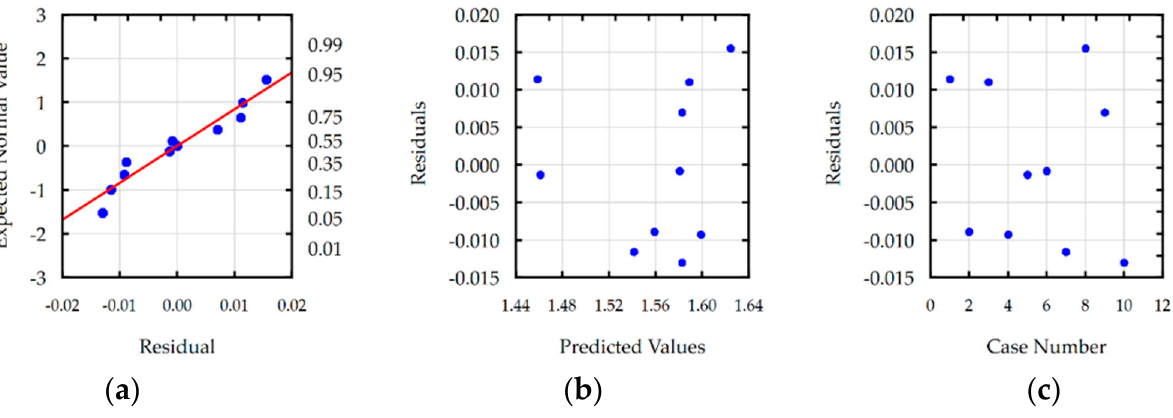
Figure 9. Plots for the model of slot width s: ( a ) the normal plot of residuals; ( b ) the residuals versus the predicted values; and ( c ) the residuals versus the case number.